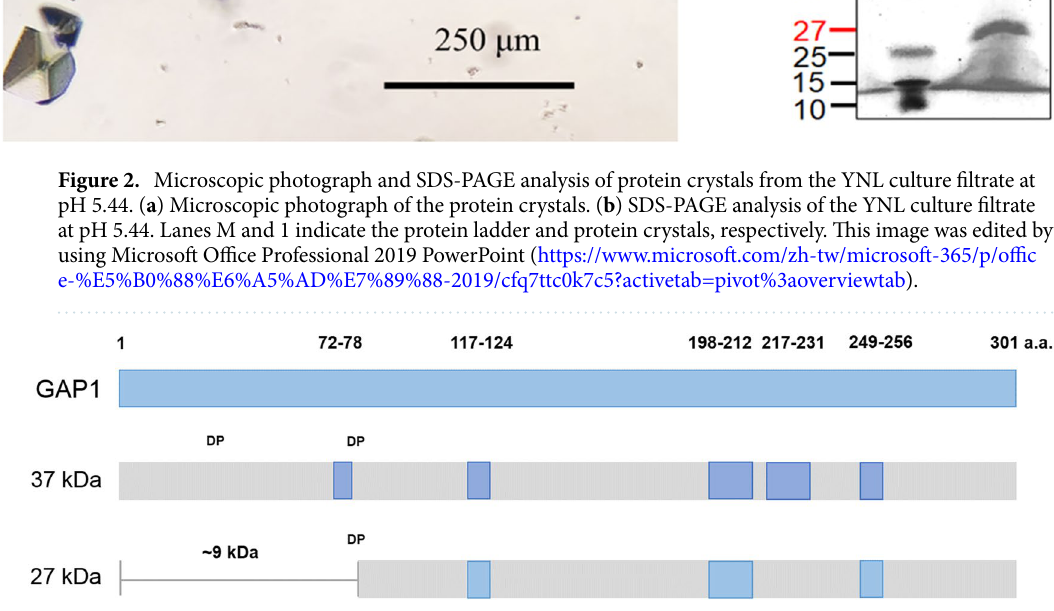
Figure 3. Schematic diagram of the peptides that matched to glyceraldehyde-3-phosphate dehydrogenase (GAP1) from the 37-kDa and 27-kDa protein bands in SDS-PAGE analysis. This image was created by using Microsoft Office Professional 2019 PowerPoint (https:// www. micro soft. com/ zh- tw/ micro soft- 365/p/ offic e-% E5% B0% 88% E6% A5% AD% E7% 89% 88- 2019/ cfq7t tc0k7 c5? activ etab= pivot% 3aove rview